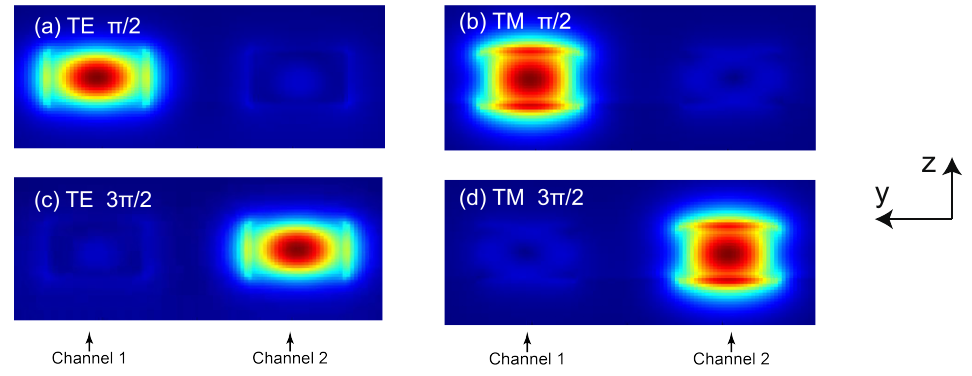
Figure 6. The output mode profiles for TE and TM polarizations at Channel 1 and Channel 2 with respect to different phase shifts at 1550nm. ( a , c ) Output mode profiles of TE polarization with π /2 and 3 π /2 phase shift. ( b , d ) Output mode profiles of TM polarization with π /2 and 3 π /2 phase